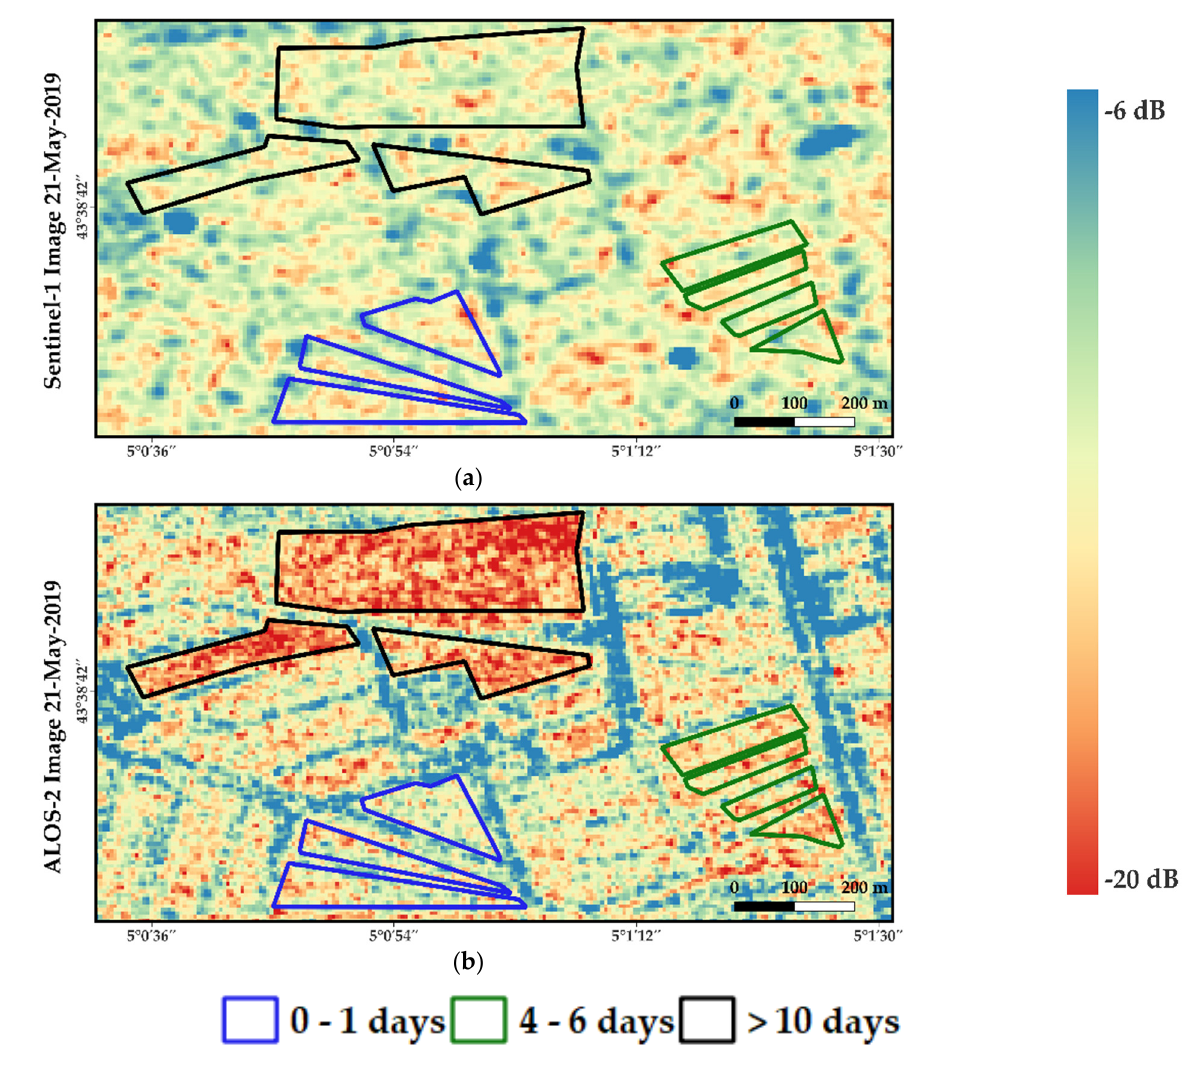
Figure 6. Examples of the differences in the SAR backscattering coefficients for grassland plots as a function of the time difference between the last irrigation event and the SAR acquisition date ( ∆t) on 21/05 for ( a ) the S1 C band in VV polarization and ( b ) ALOS-2 L band in HH polarization. Blue, green, and black represent plots with ∆t from 0–1 days, 4–6 days, and more than 10 days, respec-